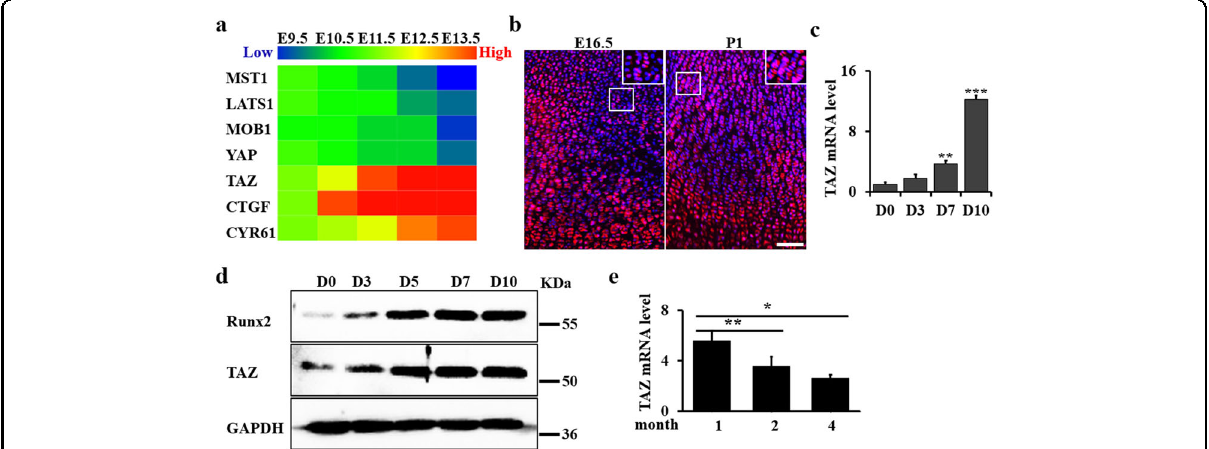
Fig. 1 TAZ expression is gradually increased during chondrogenic differentiation. a Heatmap analysis of TAZ-associated genes in early murine limb (from E9.5 to E13.5; GSE30138 32 ). b Representative immuno fl uorescence-stained images of tibiae from WT mice at the ages of E16.5 and P1, labeled for TAZ and stained for DAPI. Scale bars, 75 μ m. c qRT-PCR analysis of the chondrocyte differentiation markers of micromass culture as indicated time. d Whole-cell lysates from micromass culture were immunoblotted with antibodies against TAZ, Runx2, and GAPDH. e qRT-PCR analysis of TAZ expression using the articular cartilage from the WT mice at 1, 2, and 4 months. The experiment was independently repeated for three times. Error bars were the means ± SEM of triplicates from a representative experiment. * P < 0.05, ** P < 0.01, *** P <